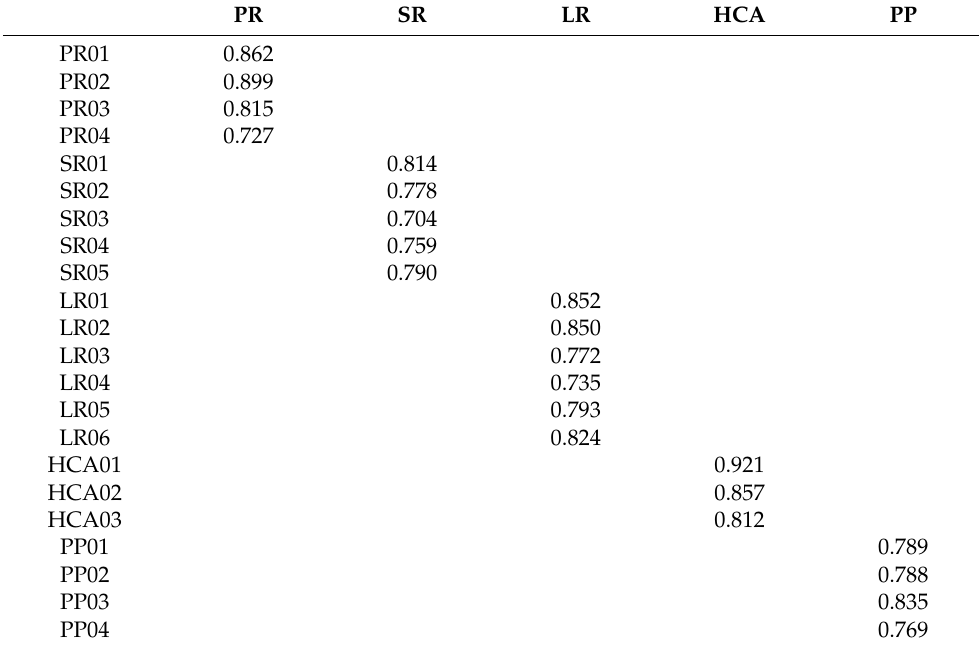
Table 5. Construct loadings for the variables used.